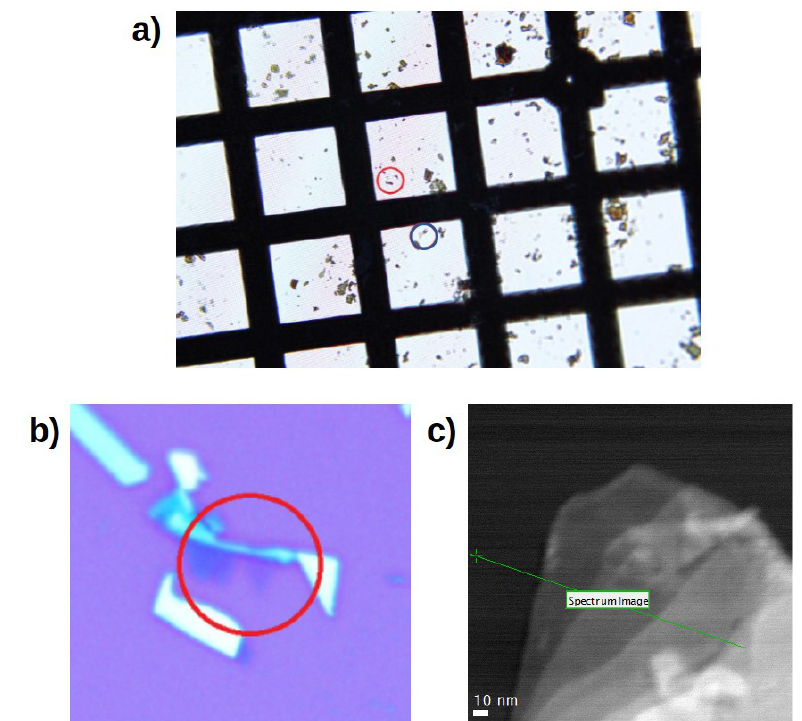
Figure A1. Optical microscopy and STEM characterization of atomically thin regions of interest. ( a ) Low-mag optical microscopy image showing two regions of interest where particularly thin alloy flakes have been found (red and blue circles, respectively). ( b ) High-mag optical microscopy image showing the region of interest seen in the red circle of the low-mag image. ( c ) STEM micrograph of the same alloy flake shown in the optical